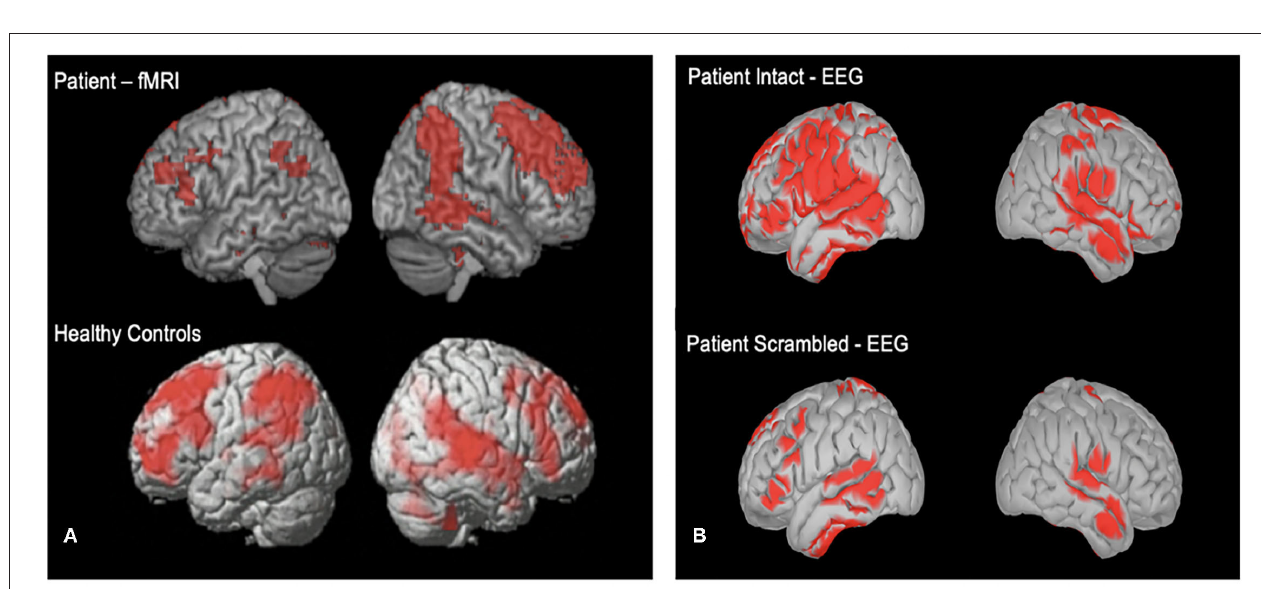
FIGURE 3 | Results for the hierarchical auditory task in two acutely unresponsive patients. The top panel shows activity to the sound perception contrast (sound > silence), the middle panel shows activity to the speech perception contrast (speech > signal correlated noise), and the lower panel assessed language processing (complex language > pseudoword sentences). Results are thresholded at p < 0.001, uncorrected and masked inclusively by the healthy control group’s results for each respective contrast and displayed on the patient’s own structural image.